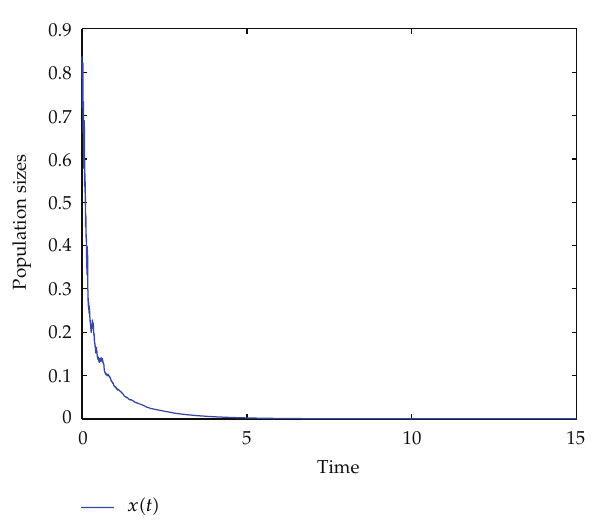
Figure 1: Stochastic extinction. The horizontal axis and the vertical axis in this and following figures represent the time t and the populations size x (cid:3) t (cid:4) , step size Δ t (cid:5) 0 . 001 and x (cid:3) 0 (cid:4) (cid:5) 0 . 8.